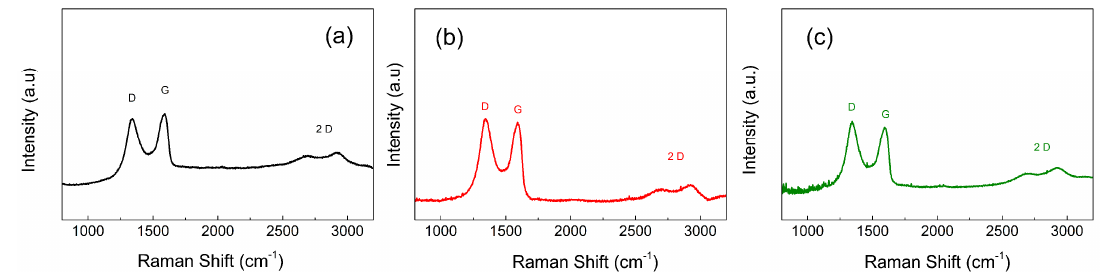
Figure 4. Raman spectra of the neat GO ( a ), GO-PHEMATMS − 1 ( b ), and GO-PHEMATMS-2 ( c ).